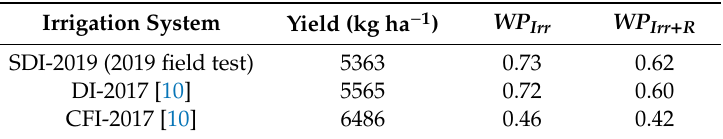
Table 5. Grain yield, irrigation water productivity ( WP Irr ) and water productivity considering irrigation and rain ( WP Irr + R ) in subsurface drip irrigation (SDI), surface drip irrigation (DI) and continuous flooding irrigation (CFI) in Baix Ter area. Irrigation System Yield (kg ha − 1